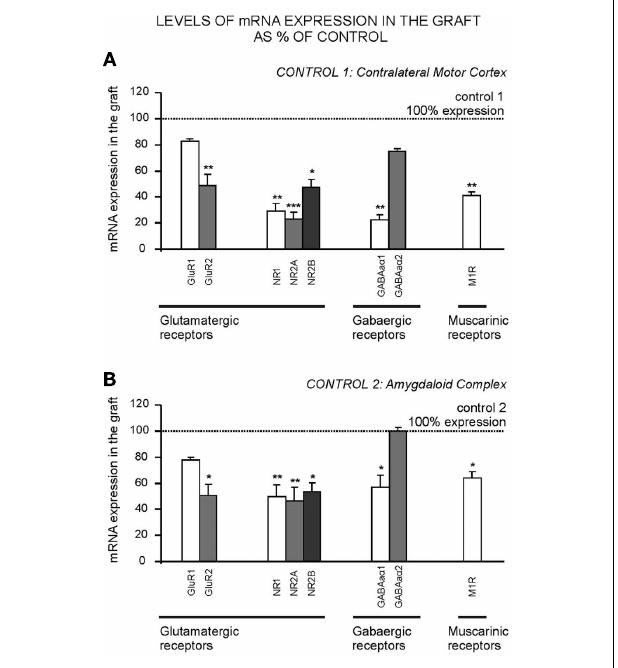
FIGURE 2 | mRNA expression levels of glutamatergic, GABAergic, and muscarinic receptors in amygdaloid grafts. Expression of NR1, NR2A, NR2B, GluR1, GluR2, GABAa α 1 and GABAa α 2 receptor subunits, and M1 type receptor mRNA, was measured by RT-qPCR. qPCR products were generated from total RNA isolated from transplant, contralateral motor cortex or amygdaloid complex block tissues ( n = 3–4 in each group), through the use of gene-specific primers for each receptor subunit or subtype.The y -axis in A and B represents graft mRNA expression as percentage of the corresponding control that was either (A) the contralateral motor cortex (control 1) or (B) the amygdaloid complex (control 2). mRNA expression in control tissue normalized to 100%. Data show mean ± SEM. * p ≤ 0.05; ** p ≤ 0.01. M1R, muscarinic M1 receptor.